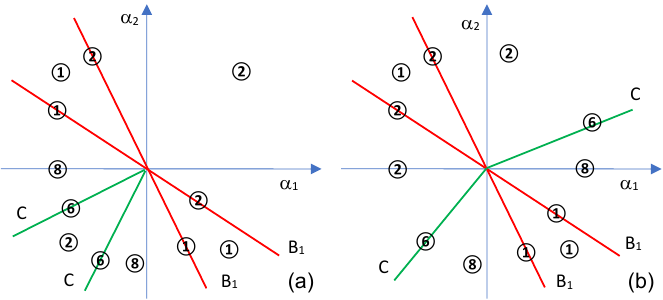
Figure 5. Bifurcation diagrams when ∆ 1 > 0 and ( a ) when case I a1, III b1, or IV b2 holds; ( b ) when case I a2, III b2 or IV b1 holds. The numbers represent the corresponding phase